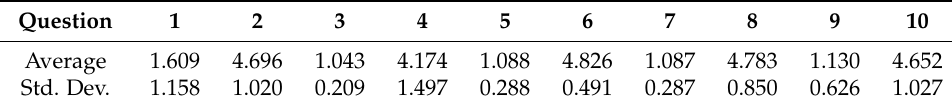
Table 2. Results of the SUS questionnaire